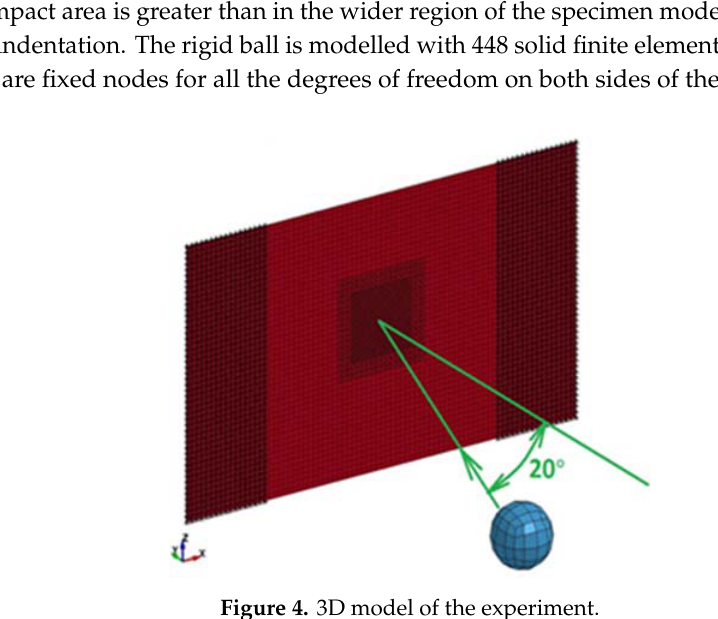
Figure 4. 3D model of the experiment.